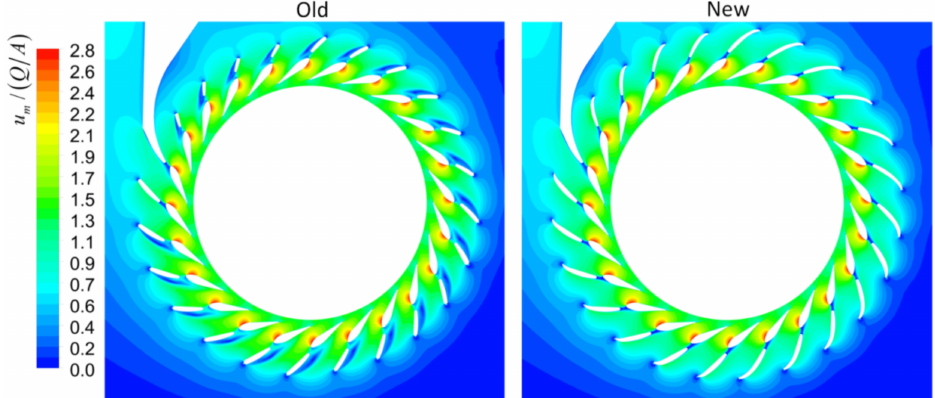
Figure 13. Flow velocity at the tandem cascade horizontal plane in case 2 hydraulic turbine functions of the inlet area of the spiral case and the turbine